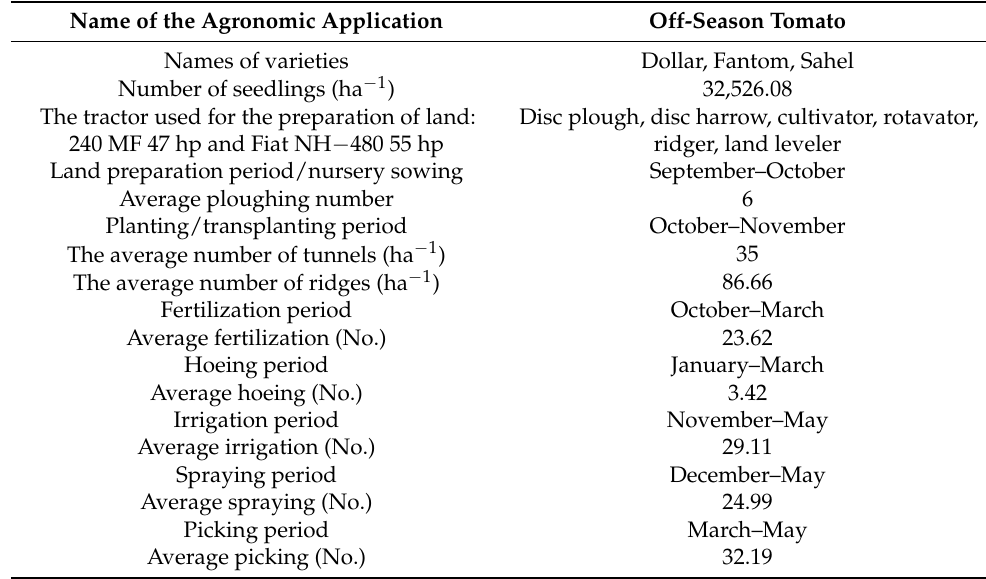
Table 2. Agronomic application in tomato production under tunnel